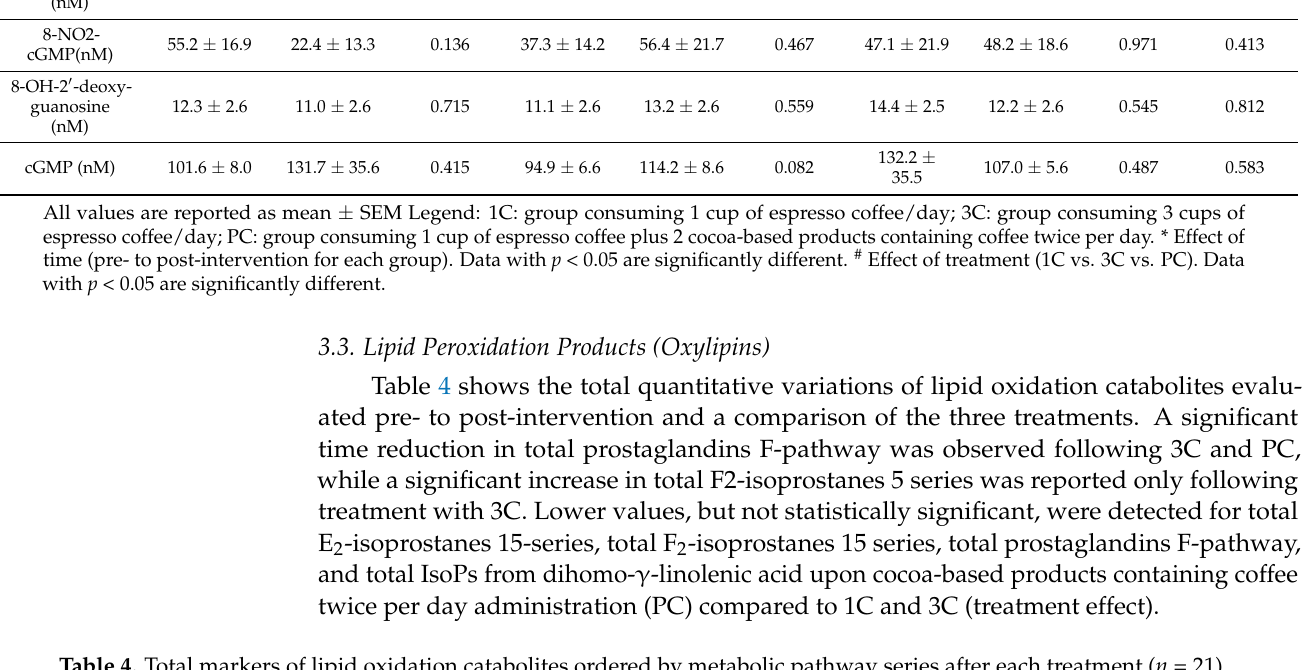
Table 4. Total markers of lipid oxidation catabolites ordered by metabolic pathway series after each treatment ( n = 21).